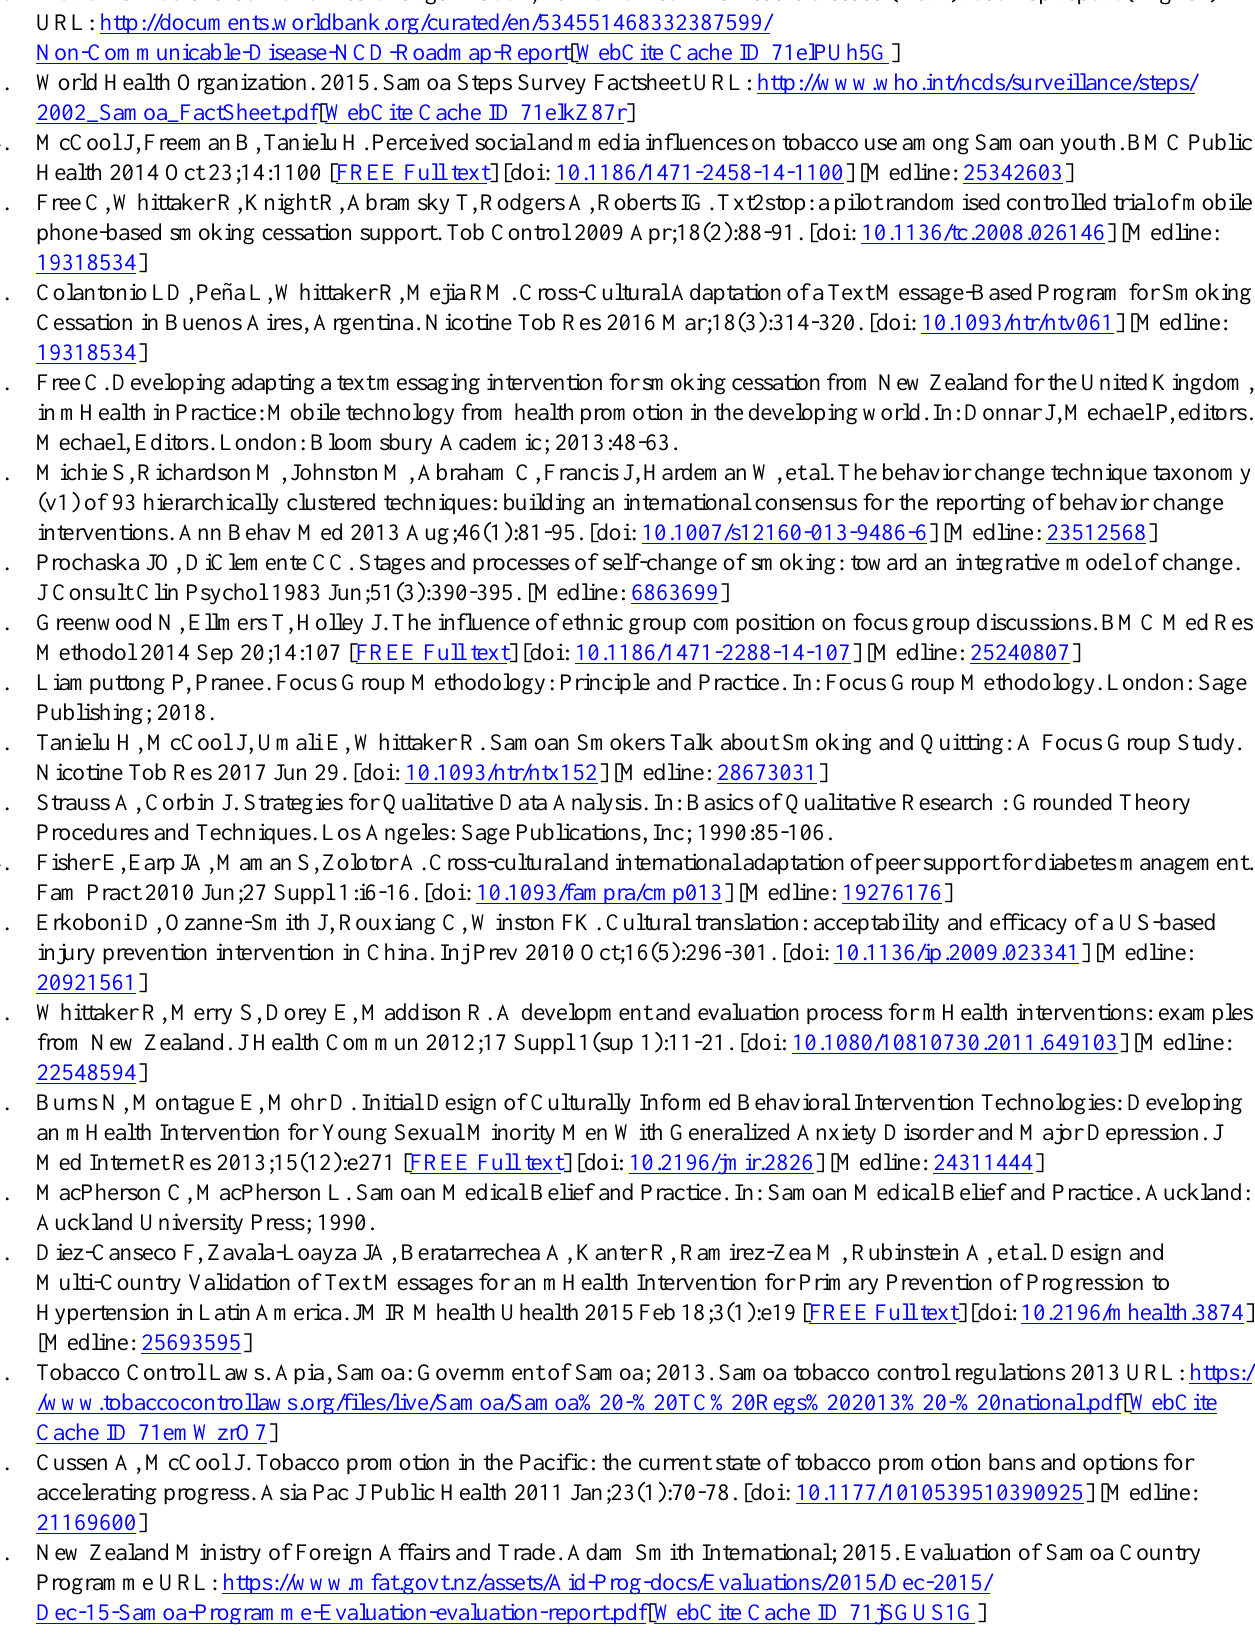
Abbreviations LMICs: low- and middle-income